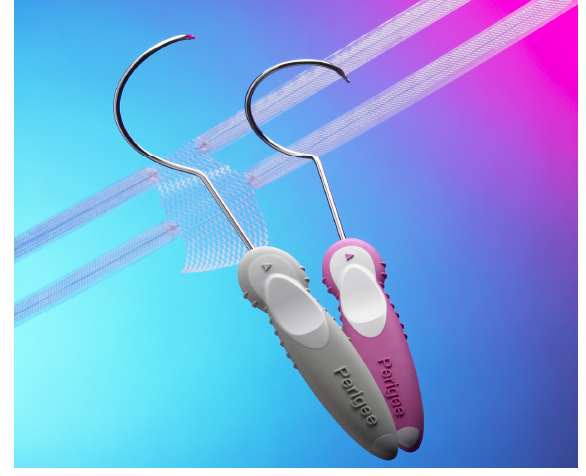
FIGURE 1 . Perigee System by American Medical